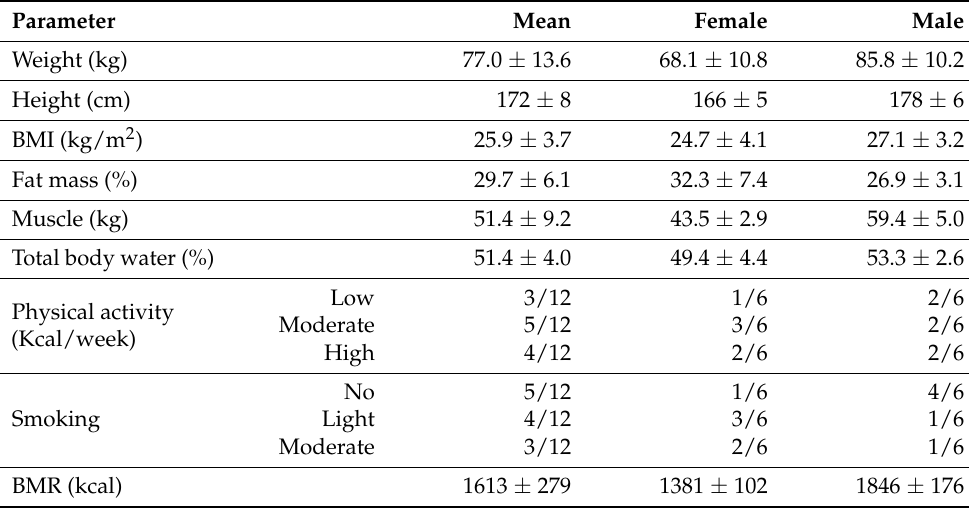
Table 1. Baseline characteristics of the participants.